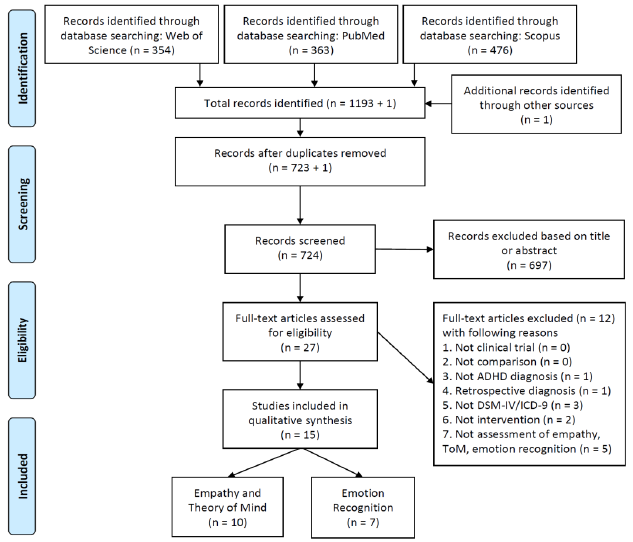
Figure 1. PRISMA flowchart showing the process of identification and selection of